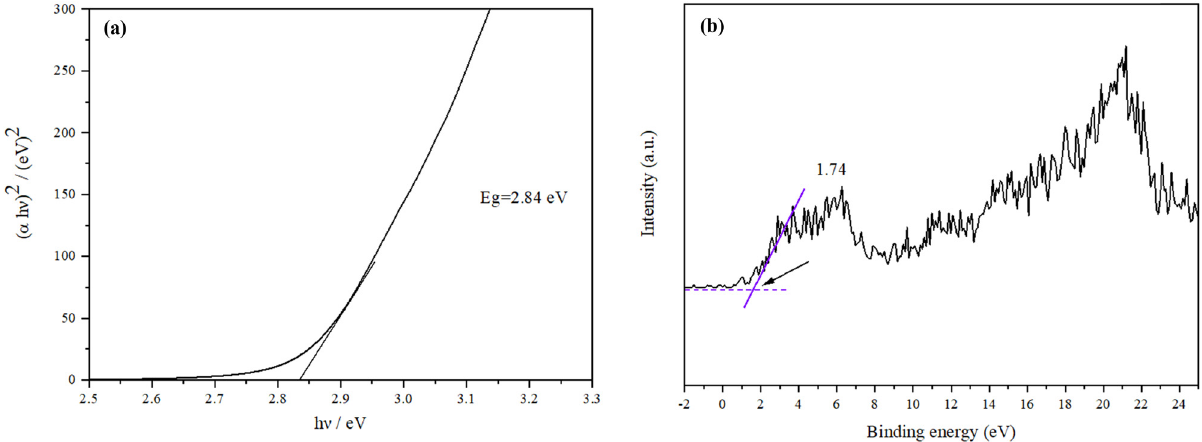
Figure 10: ( a ) Spectrum expressed as the Kubelka - Munk function and ( b ) the VB energy spectrum